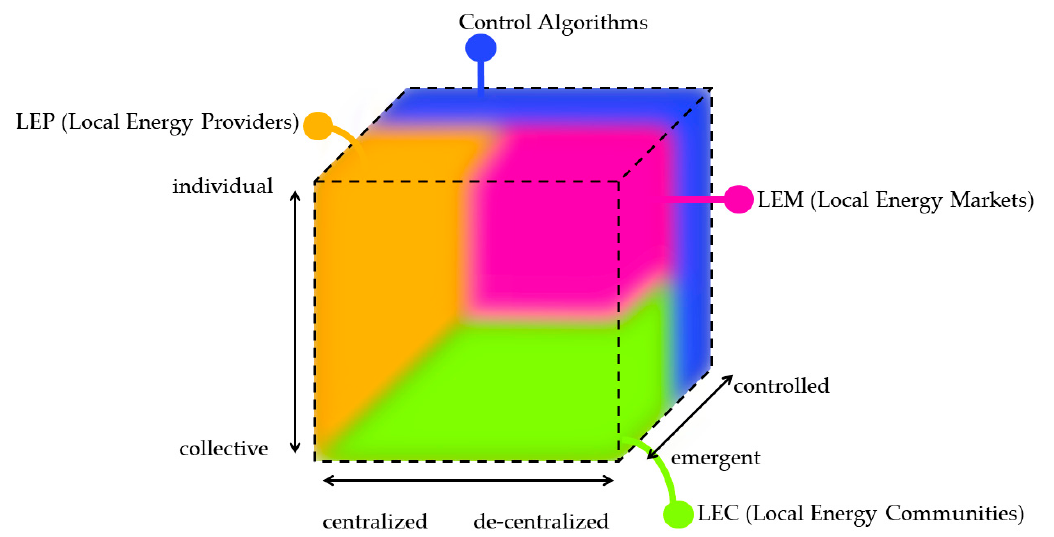
Figure 2. 3D map of the behaviours in a district scale renewable energy system from [39]. Figure 3. District scale renewable energy systems behaviour map. Figure 3. District scale renewable energy systems behaviour map.